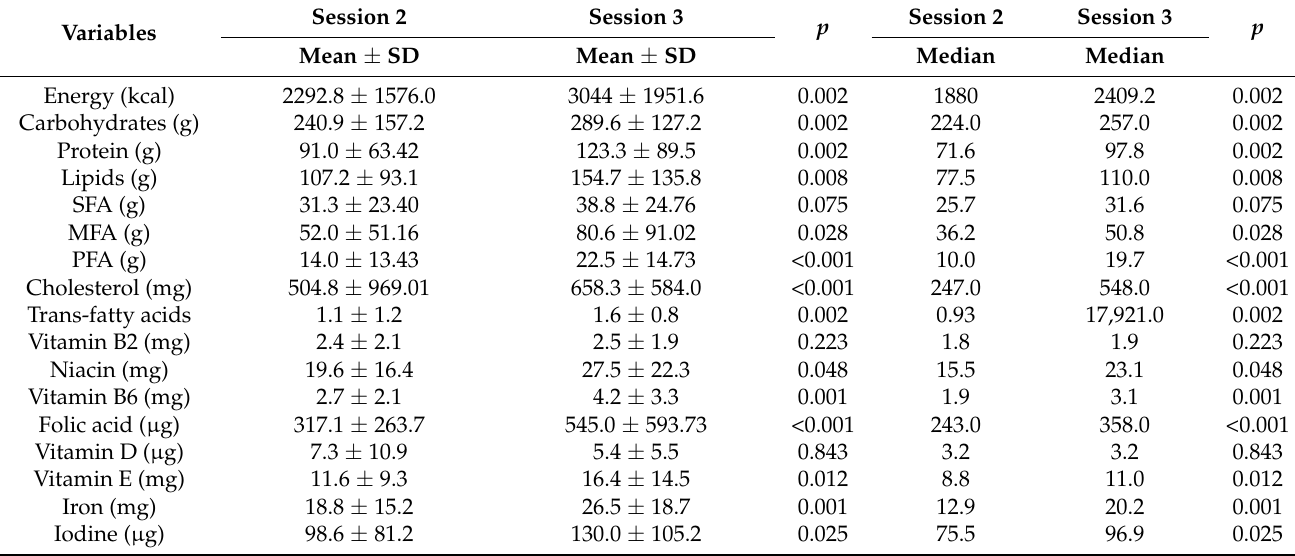
Table 3. Dietary intake before Ramadan (Session 2) and immediately afterwards (Session